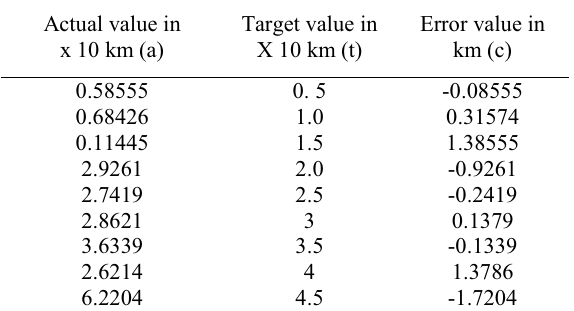
Table 2.Numerical values of the FL error of hybrid approach for double circuit of double line to ground fault (50-100km) Actual value in x 10 km (a)